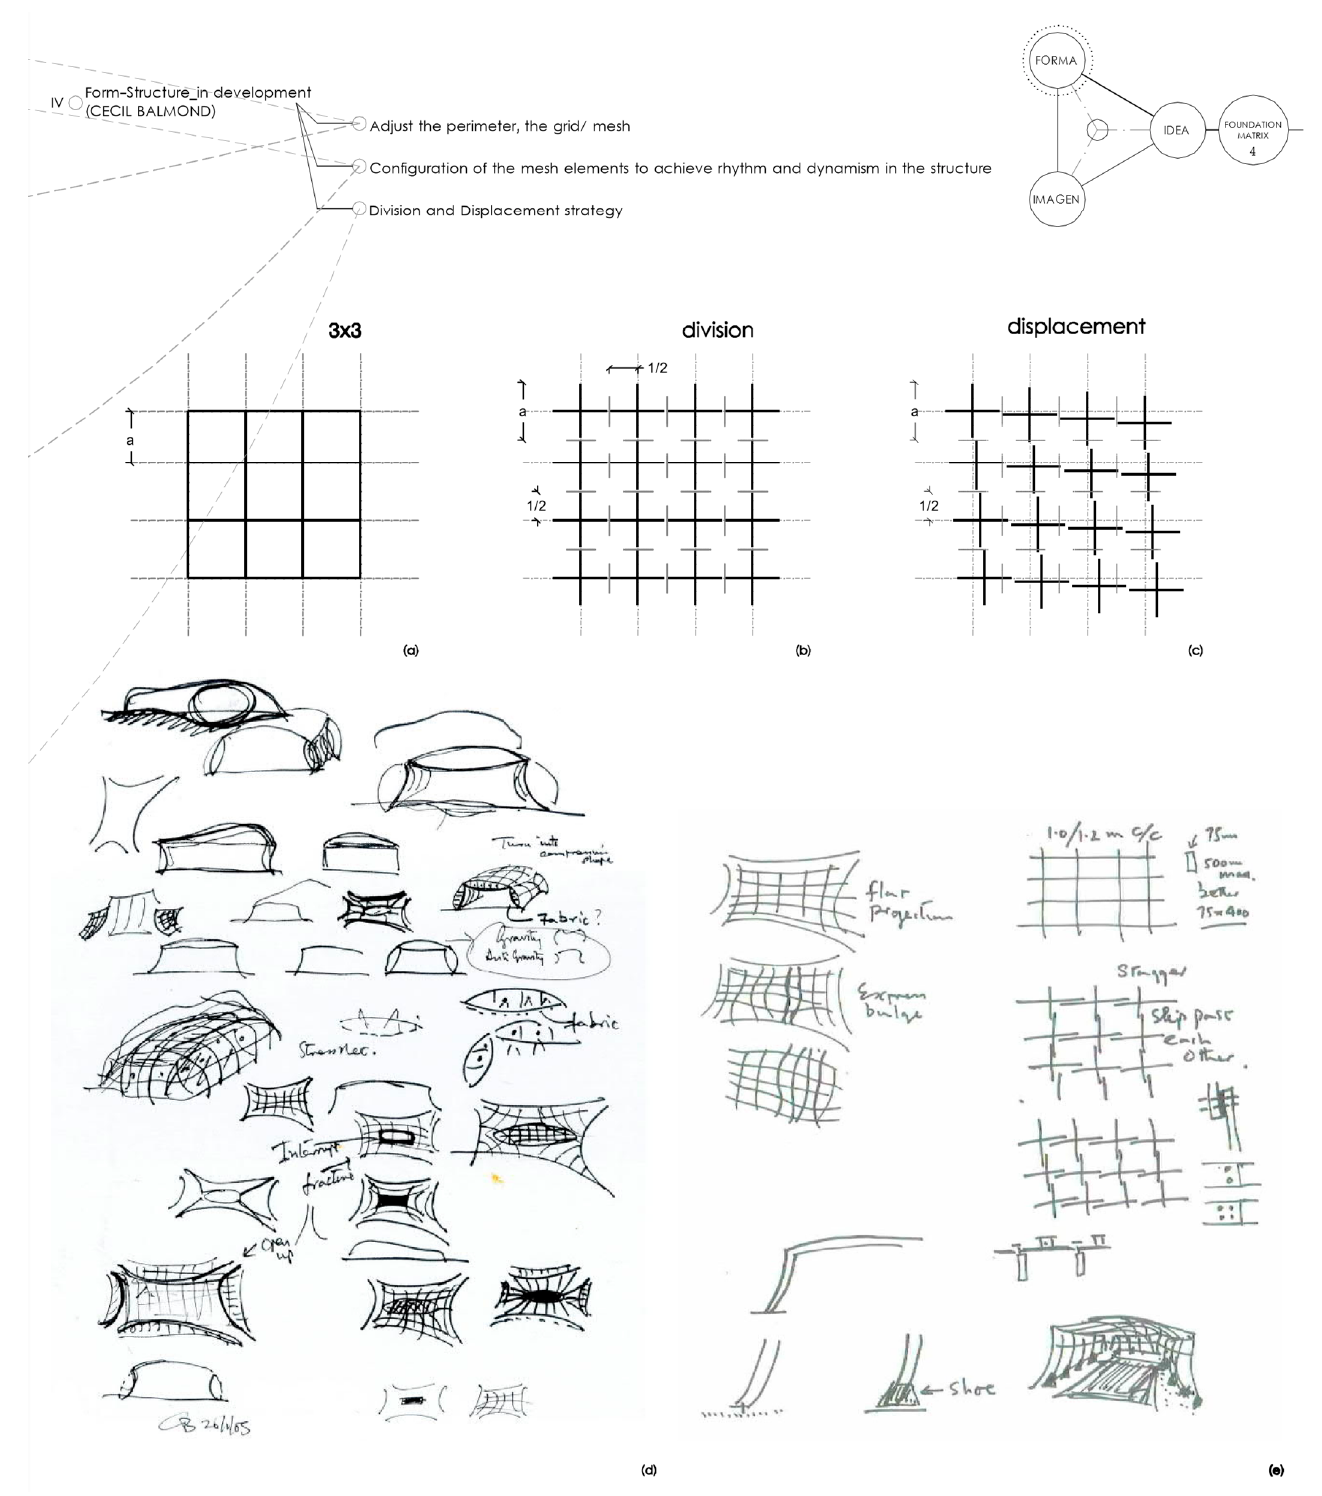
Figure 9. Foundation matrix 4. ( c ) del Río-Calleja interpretation based on Balmond sketches [27]; ( d ) sketches by Balmond [70]; ( e ) sketches by Balmond [27].